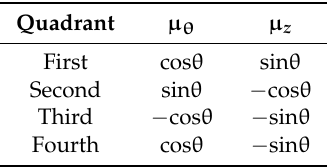
Figure 3. The quadrant distribution of the hard ‐ coating cylindrical shell.